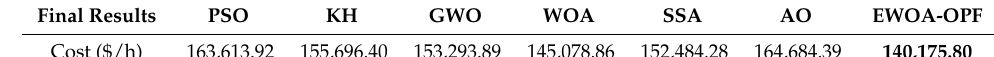
Table 9. Final results of OPF for IEEE 118-bus test system on Case 2.